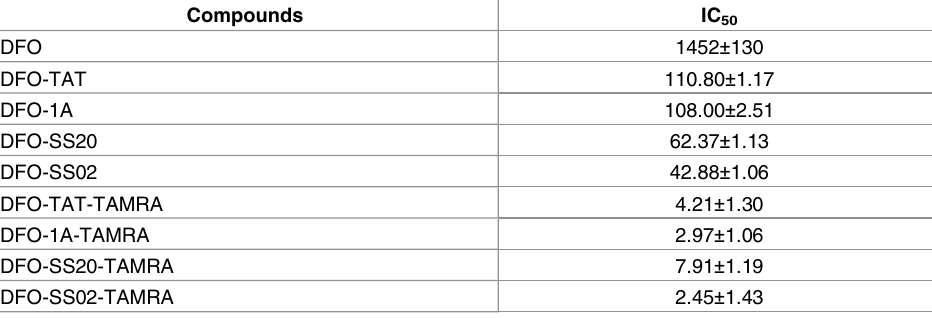
Table 1. IC 50 ( μ M) of mtDFO, DFO and TAMRA-tagged mtDFO in A2780cells after 24